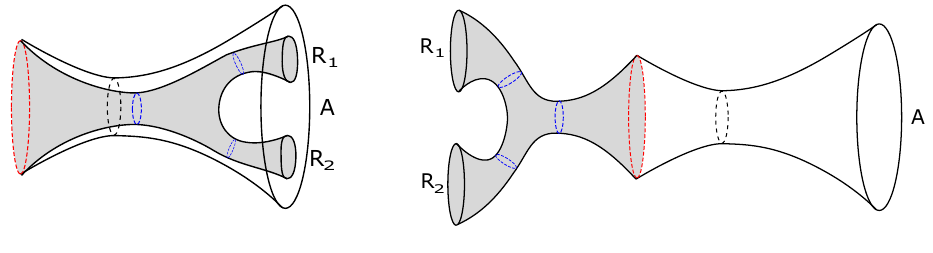
Figure 5 . The spatial slice of the glued geometry when we purify the inception black hole with a two boundary wormhole. Left: since we glue convex surfaces to convex surfaces, the original boundary and the purifying systems are naturally on the same side. Right: in order to increase clarity, we \unfold" the diagram on the left when we depict its various